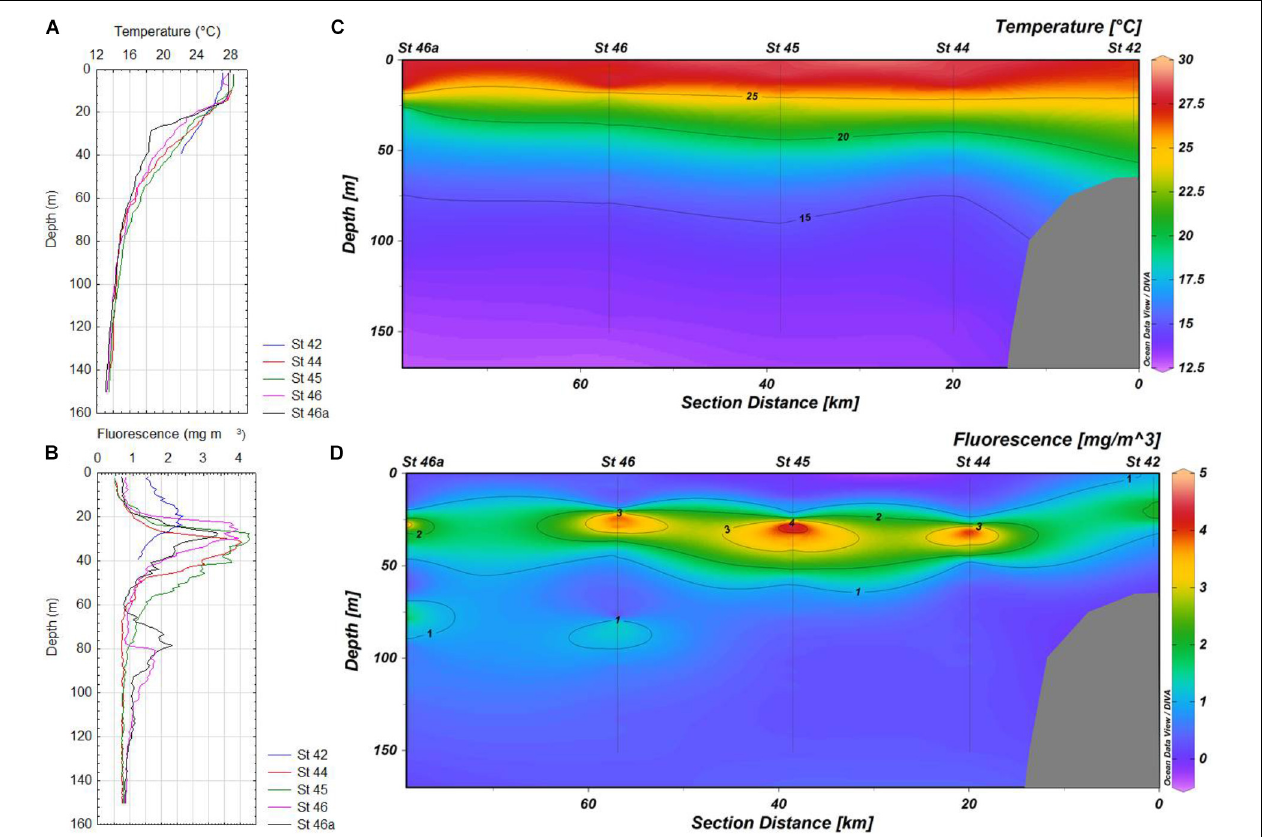
FIGURE 4 | (A,B) Vertical profiles of temperature and in situ fluorescence for stations 42-46a of the transect in Acapulco, respectively. (C,D) Maps of the distribution of temperature and in situ fluorescence for stations 42-46a in Acapulco,